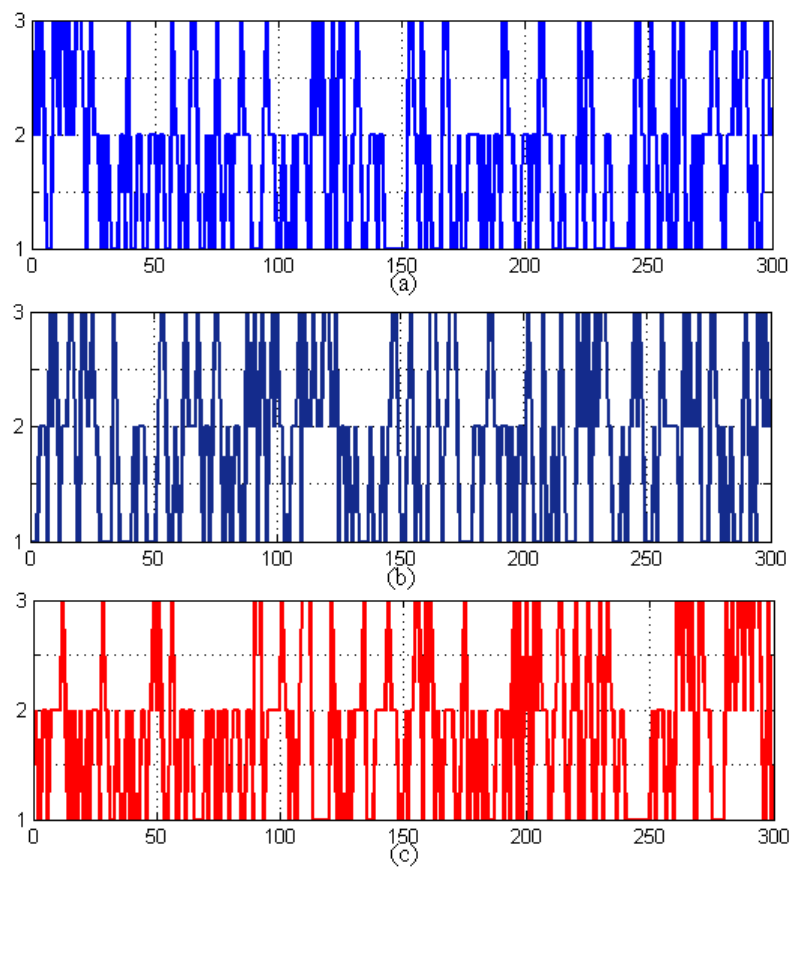
Figure 9. ( a ) Consumption pattern (CP) predicted states; ( b ) tap event (TE) predicted states and ( c ) seepage event (SE) predicted states against 300 future points (hours for ( a ) and seconds for ( b ) and ( c )) from